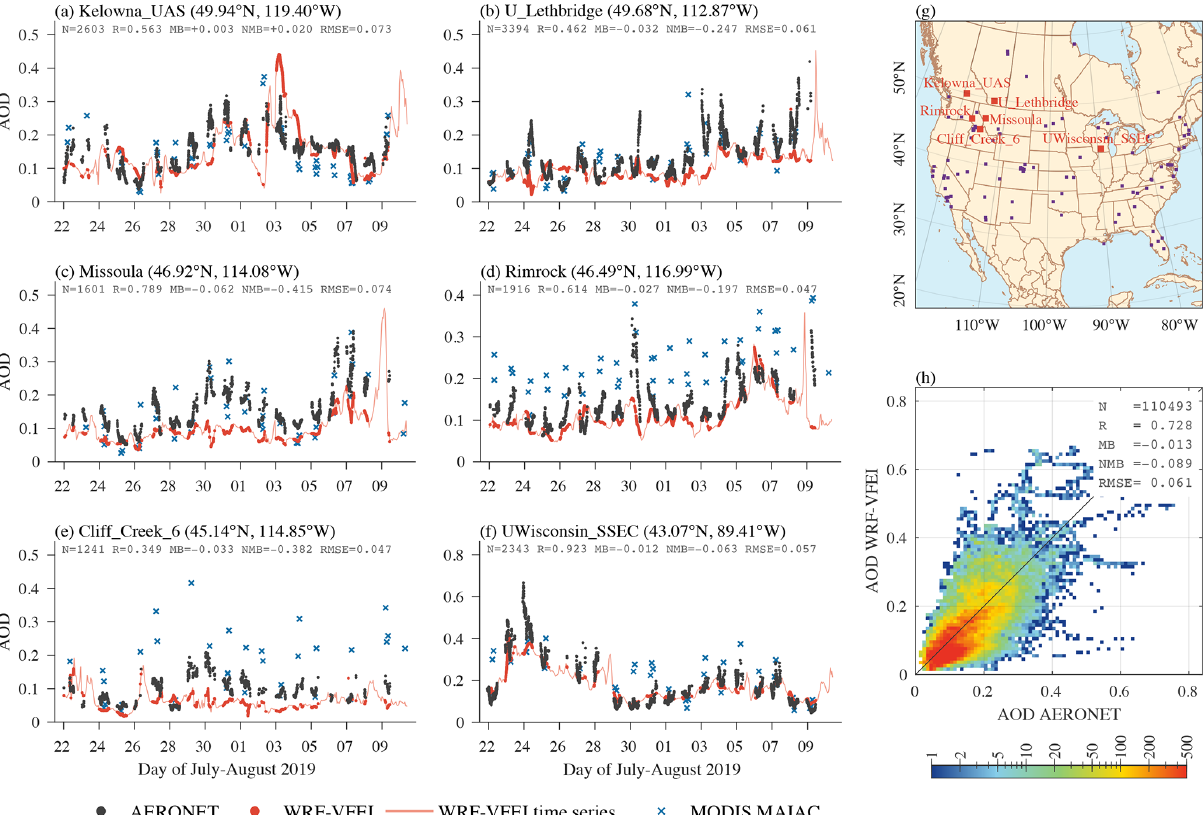
Figure 10. Same as Fig. 7 but comparing AERONET stations from North America between 22 July and 10 August 2019.